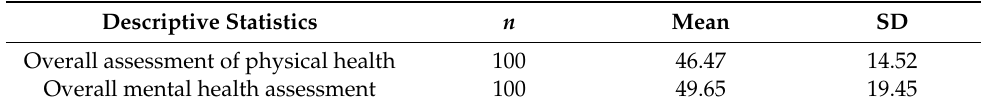
Table 3. The summary measures from the SF-36v2 questionnaire.